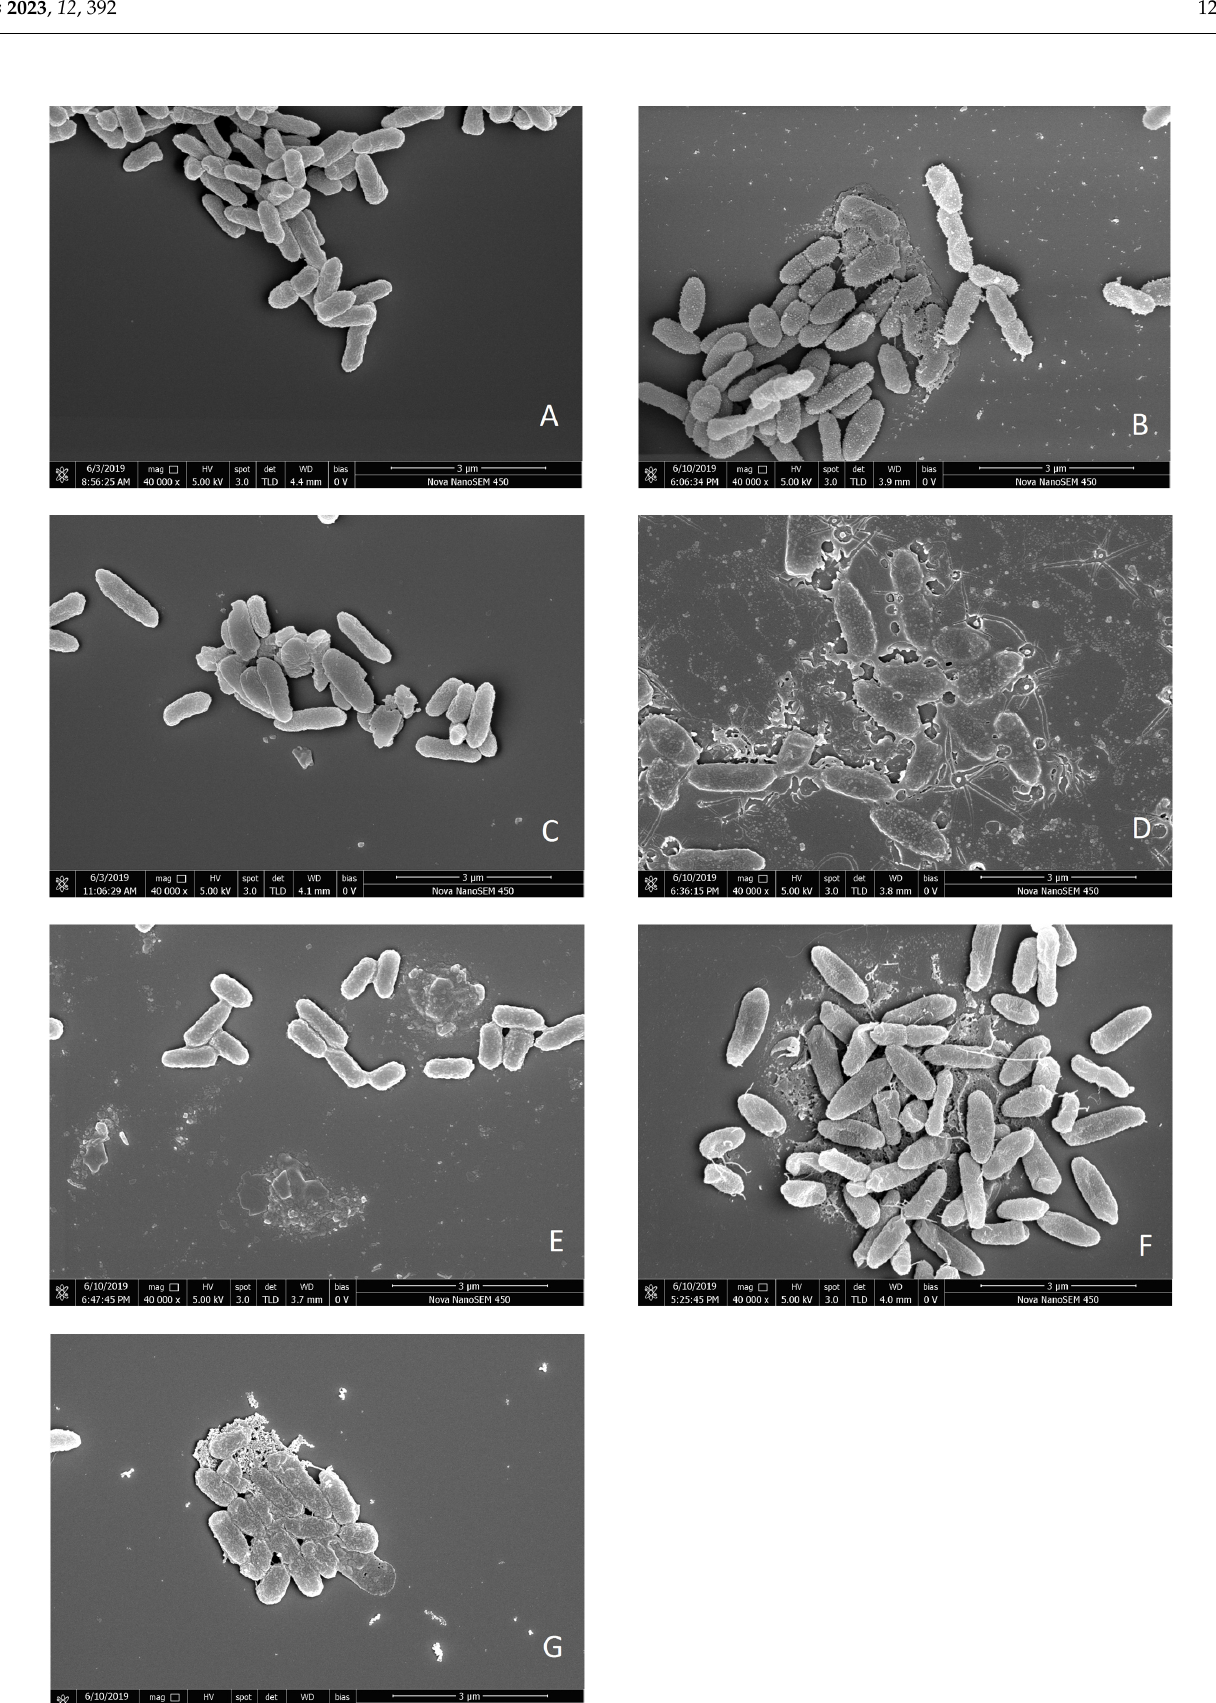
Figure 6. Scanning electron micrographs of untreated PAO1-CE ( A ) or PAO1-CE treated with Str ( B ), Car ( C ), Amp ( D ), Ter ( E ), Tmp ( F ), or Cip ( G ) at 2 MIC for 4 h.